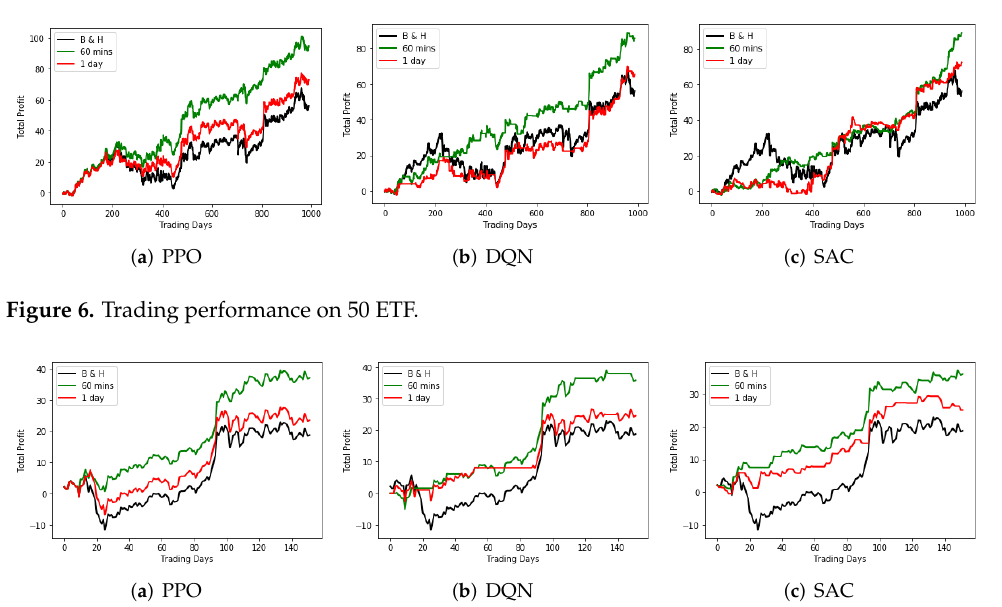
Figure 7. Trading performance on 300